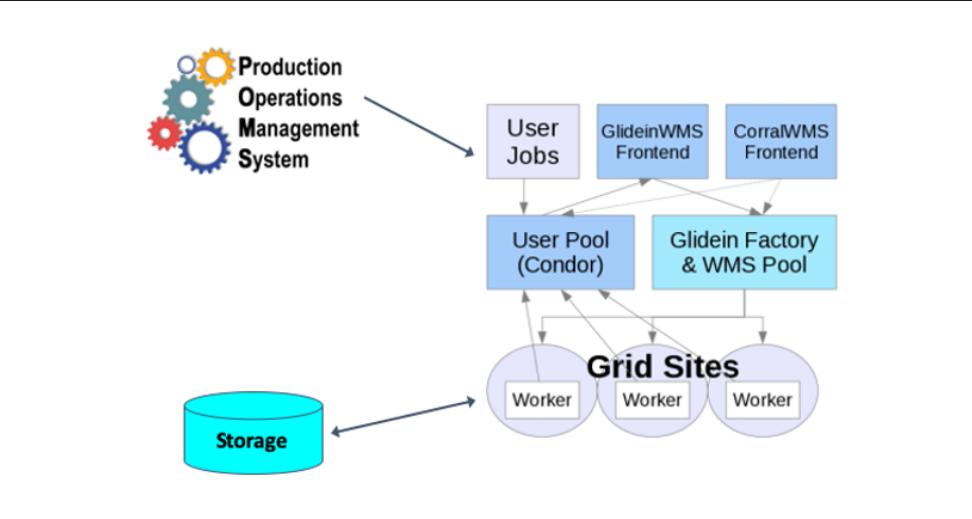
Figure 1. Overview of the current DUNE Production workflow setup used also by the ProtoDUNE detectors for data reconstruction and simulation. Production group members interact with POMS to submit jobs, which uses the Jobsub tool to submit jobs to a HTCondor schedd. GlideinWMS provisions worker node resources and jobs match to the available worker node slots. DUNE jobs interact with storage elements both at Fermilab and other sites both for input copy (or streaming for most production workflows) and output